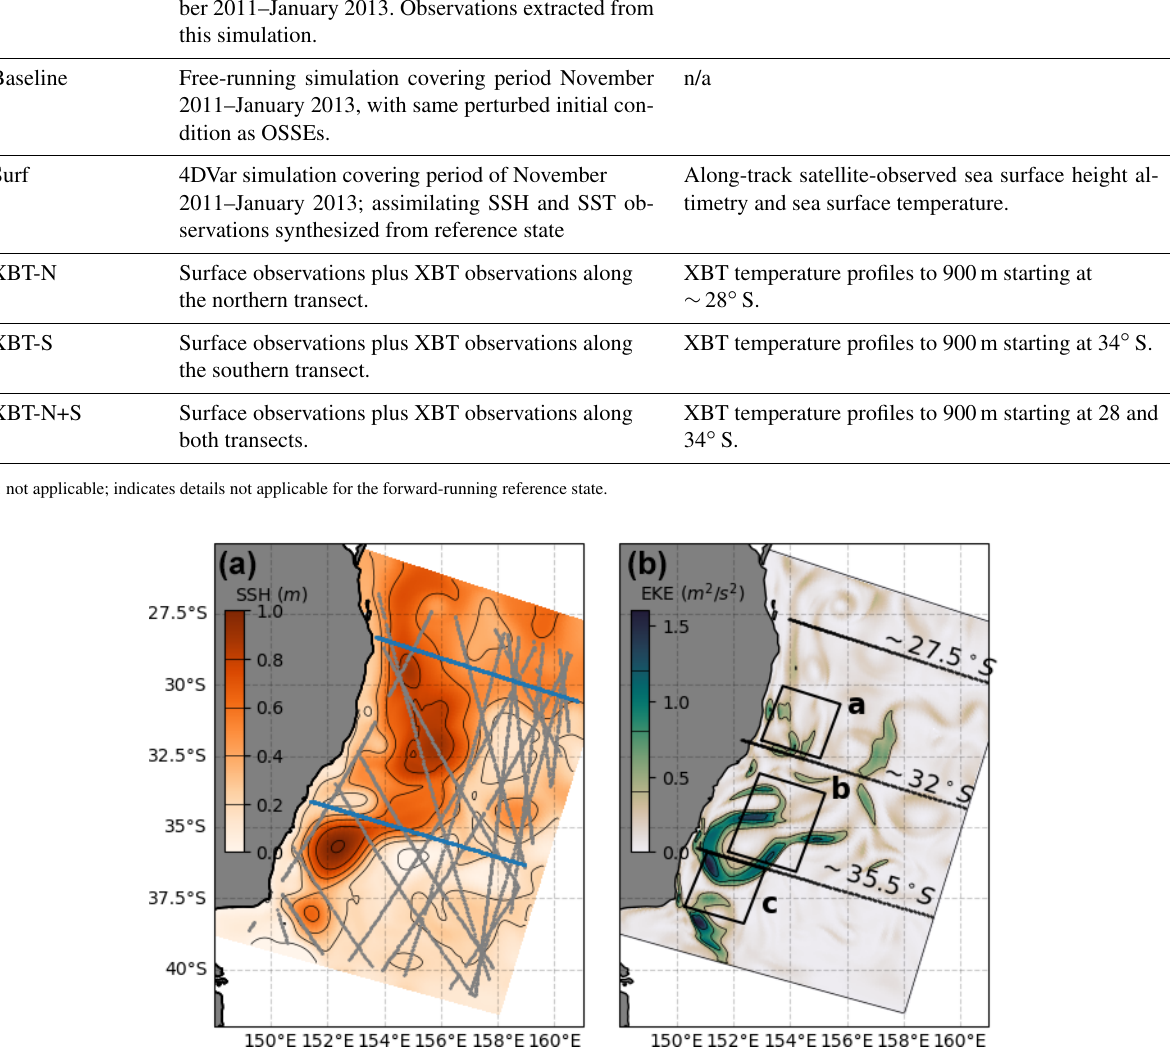
Figure 3. Snapshots of model conditions with examples of observations and analysis regions. (a) A snapshot of SSH (colour map) is shown with a single 5d cycle of SSH (grey dots) and XBT (blue dots) observations. (b) A snapshot of EKE (colour map) is shown, with boxes and lines showing key regions and diagnostic transects used in the